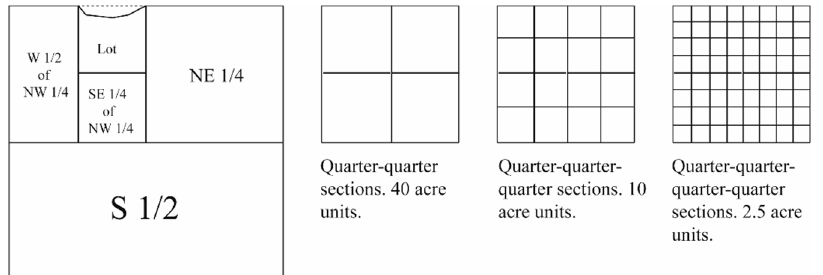
Figure 5. On the left is an example of the various PLSS-based parcel aliquots one may encounter. Quarter-quarter sections are typically the smallest sub-unit within the Public Land Survey System. Quarter-quarter sections can be quartered further using Ian Broad’s Custom Grid Tools [36].